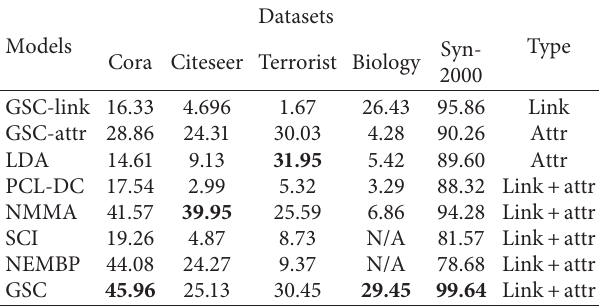
Table 3: NMI (%) of different models on five networks with node